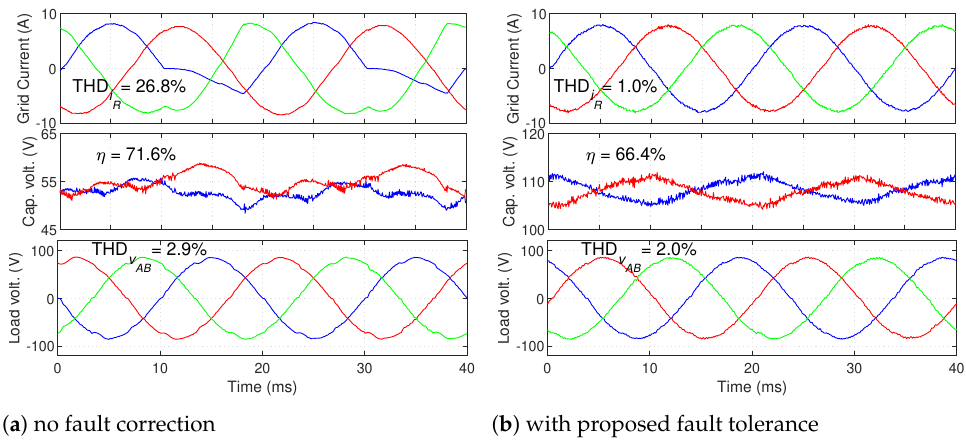
Figure 14. UPS steady-state operation after a fault in inner IGBT S R 2 : ( a ) with no fault tolerance; ( b ) with the proposed fault-tolerant